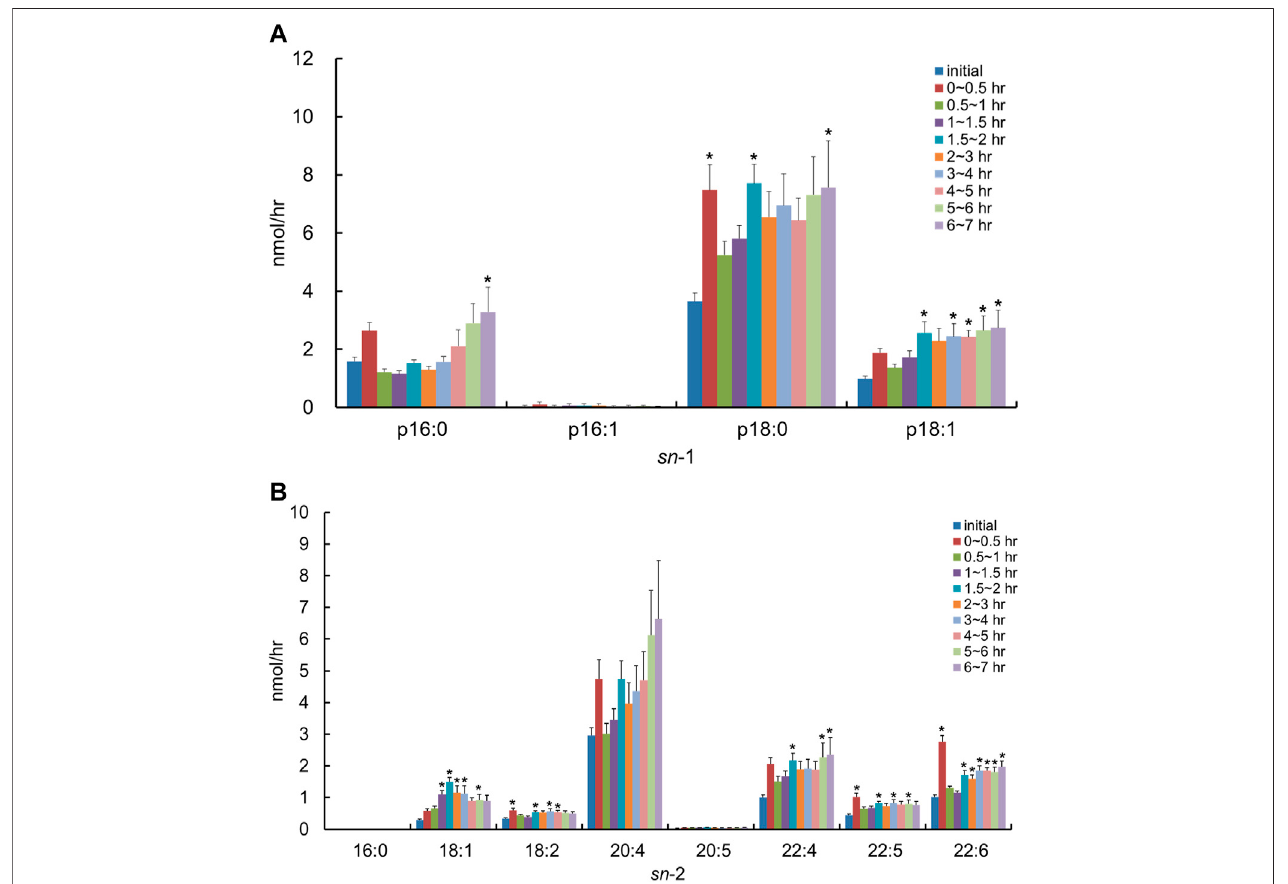
FIGURE 5 | Change in molecular species due to the classi fi cation in (A) the hydrocarbon chain at the sn -1 position and (B) FA at the sn -2 position in lymphatic PlsEtn of thoracic lymph-cannulated rats for 7 h after duodenal administration of the emulsion containing the lipid extracted from porcine brain. Data are represented as mean ± SEM ( n = 5 – 6). Asterisk indicates signi fi cant difference with respect to the values at time 0 ( p < 0.05).